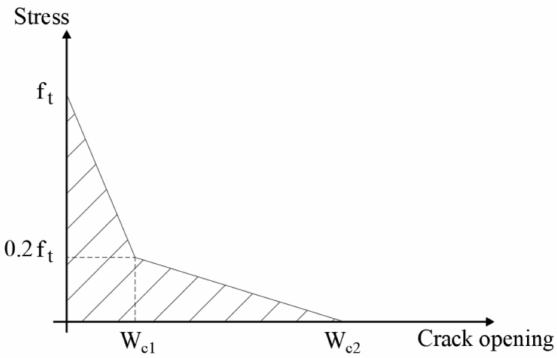
Figure 5. Tensile stress versus crack opening (tension stiffening).